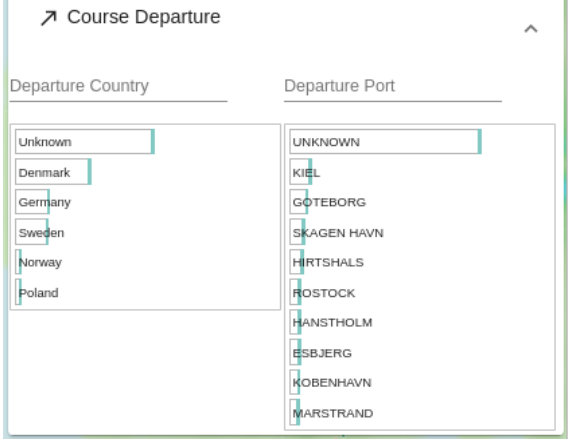
Figure 13 . Origins of Ship Trips in ARLAS Exploration. We can directly select trips starting from given ports or countries or type names in the search bar.